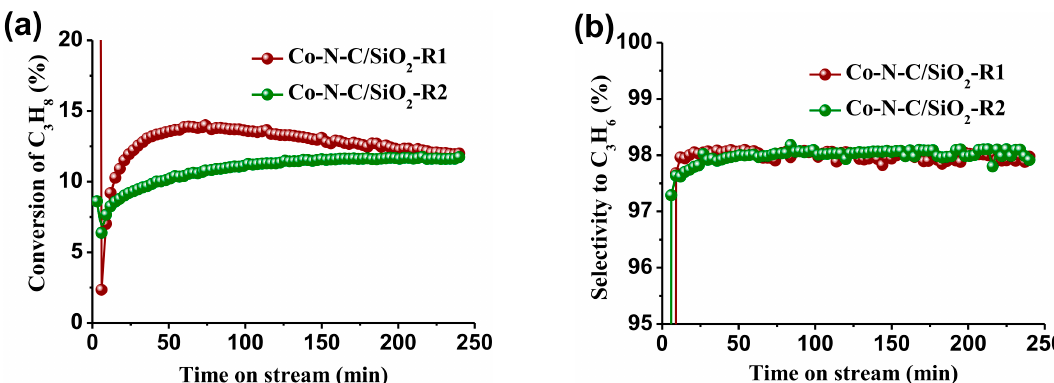
Figure 6. Propane conversion ( a ) and selectivity to propylene ( b ) as functions of time on stream over Co-N-C/SiO 2 , Co-N-C/SiO 2 -R1 and Co-N-C/SiO 2 -R2 catalysts at T = 600 °C and P = 1 atm. Gas